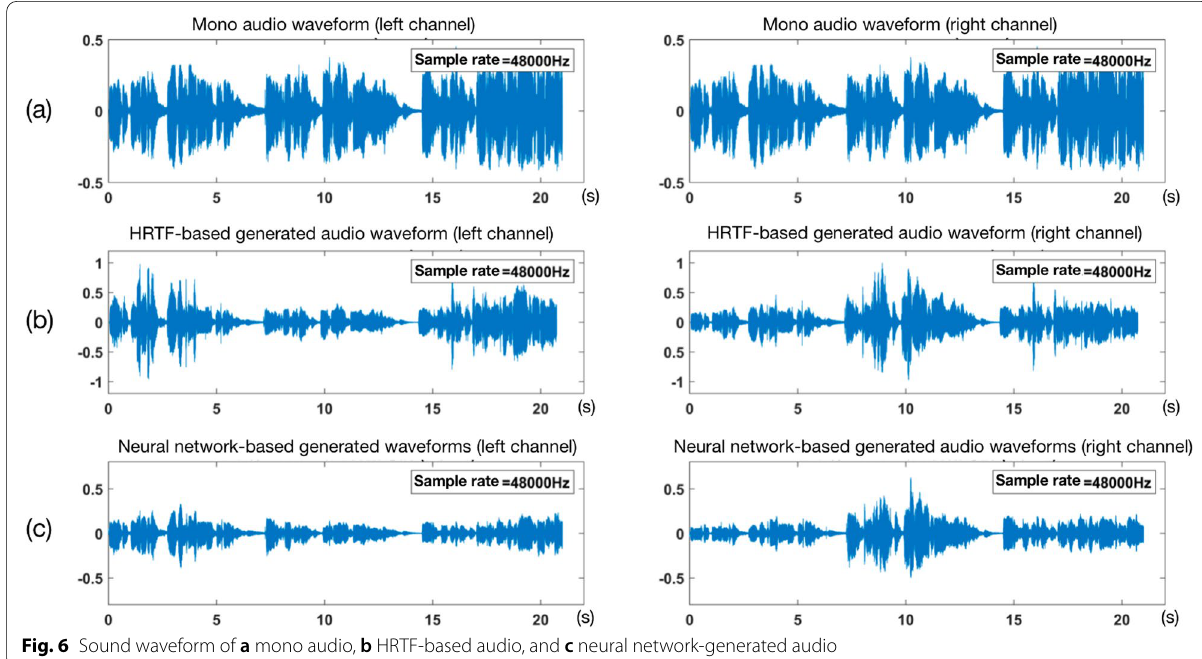
Fig. 6 Sound waveform of a mono audio, b HRTF-based audio, and c neural network-generated audio